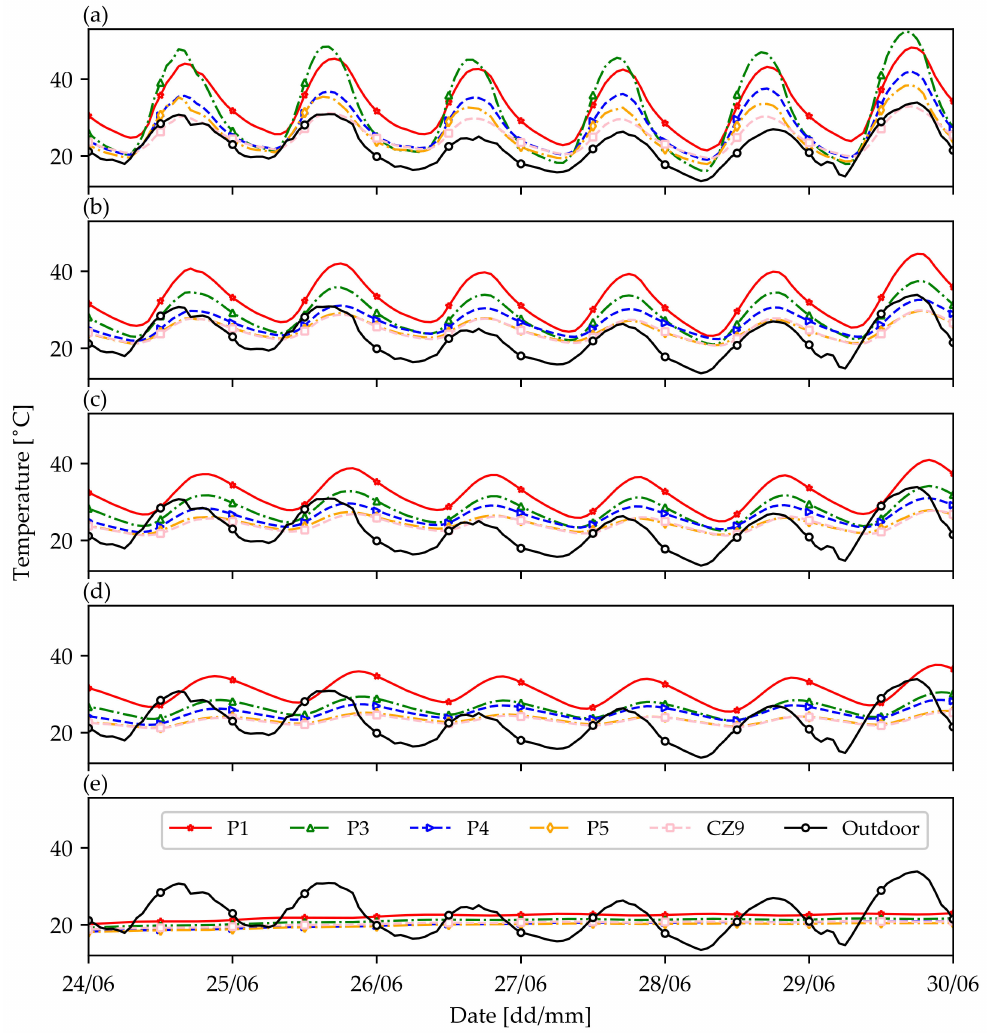
Figure 10. Temperature records at different depths: − 3 cm ( a ); − 8 cm ( b ); − 16 cm ( c ); − 24 cm ( d ); − 55 cm ( e ) during the summer period from 24 June to 30 June 2019. P1 is represented with a red solid line with star markers. P3 is represented with a green dotted line with triangle up markers. P4 is represented with a blue dotted line with triangle right markers. P5 is represented with an orange dotted line with diamond markers. CZ9 is represented with a pink dashed line with square markers. The black continuous line with round markers represents air ambient